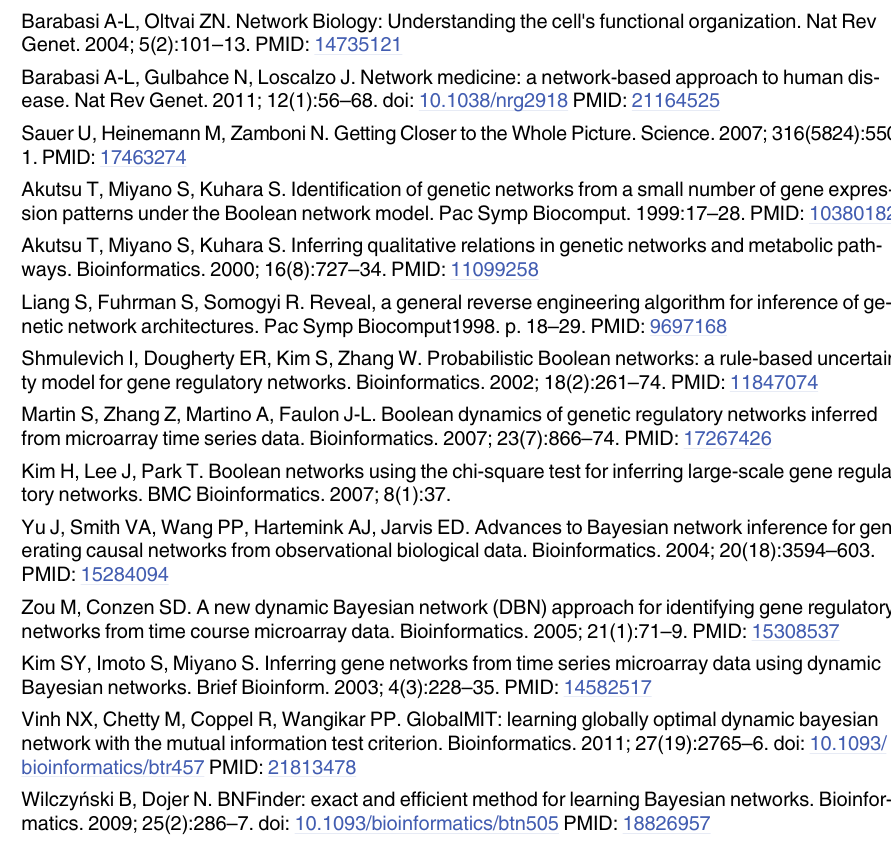
S5 Table. Comparing the performance of methods on NetSim and DREAM3 data. Median PPV, recall and F score obtained by applying broken stick, Bartlett ’ s and TSNI integral meth- ods on comparable networks of DREAM 3 challenge (E.coli2 with 15 interactions) and NetSim (median value of14 interactions). A set of 20 different networks consisting of 12 – 17 interac- tions were simulated by NetSim whereas, 4 time series provided in DREAM 3 challenge were used for E.Coli2 network. Values in parentheses show the performance when self-regulation is not